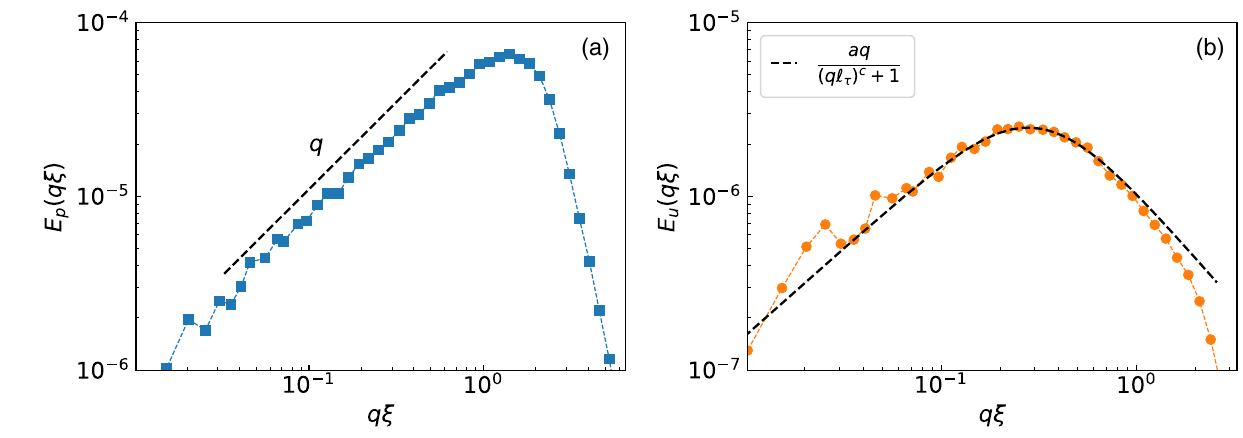
FIG. 8. Energy spectra for R ¼ 0 . 01 . (a) Order parameter energy spectra E p ð q ξ Þ . The black dashed line indicates E p ð q Þ ∼ q scaling. (b) Kinetic energy spectra E u ð q ξ Þ . A least-squares fit to the curve aq= ½ð q l τ Þ c þ 1 (cid:2) gives a ¼ 1 . 6 × 10 − 5 , c ¼ 2 . 3 , and l τ ¼ 1